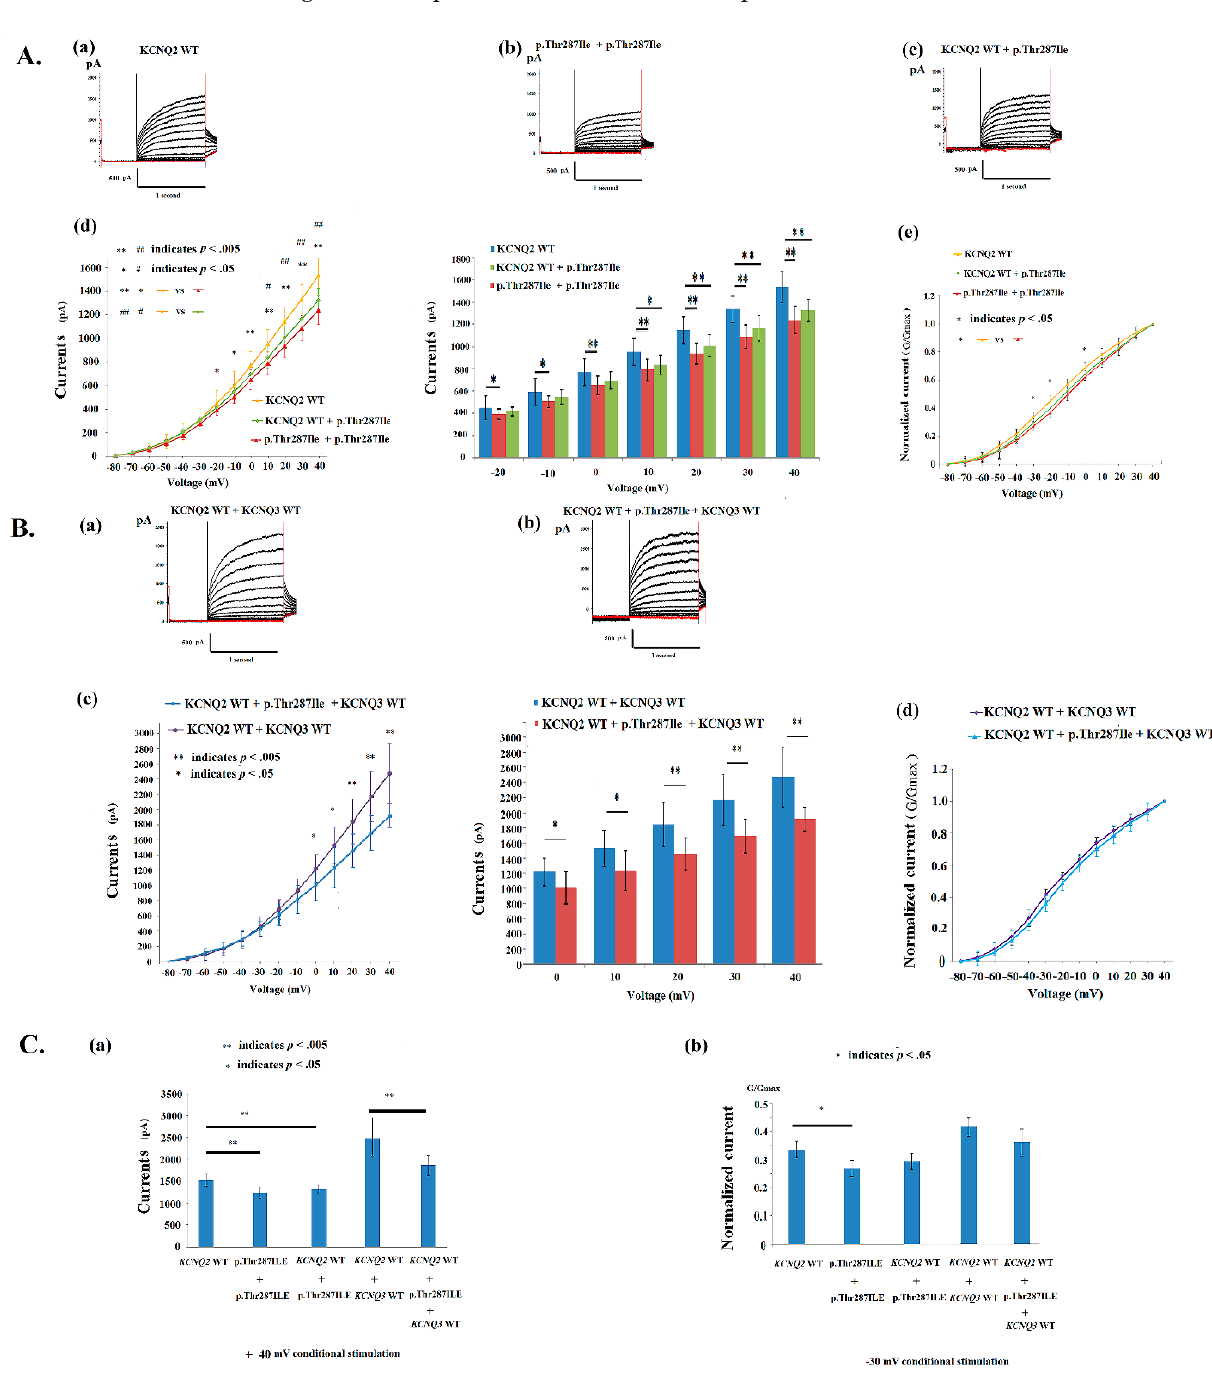
Figure 2. ( A ) Analysis of the electrophysiological properties of HEK293 cells in KCNQ2 channels. The voltage-clamp steps were from − 80 mV and +40 mV in 10-mV increments. The cells transfected with the ( a ) KCNQ2 wild type (WT) (2 µ g) ( n = 22), ( b ) homomeric p.Thr287Ile ( n = 10) (2 µ g) and ( c ) heteromeric p.Thr287Ile + KCNQ2 WT (1 µ g:1 µ g) ( n = 10). ( d ) The conductance curves exhibited lower currents in homomeric p.Thr287Ile [ p < 0.05 ( p values see Supplementary Table S1); − 20 to +40 mV] and heteromeric p.Thr287Ile + KCNQ2 WT compared with KCNQ2 WT [ p < 0.05 ( p values see Supplementary Table S1); 0 to +40 mV)] . * homomeric p.Thr287Ile versus KCNQ2 WT; # p.Thr287Ile + KCNQ2 WT versus KCNQ2 WT. ( e ) The normalized currents in homomeric p.Thr287Ile were lower (G/G max) ( p < 0.05; − 30 to − 20 mV and 0 mV) than those in cells with KCNQ2 WT. ( B ) ( a ) The KCNQ2